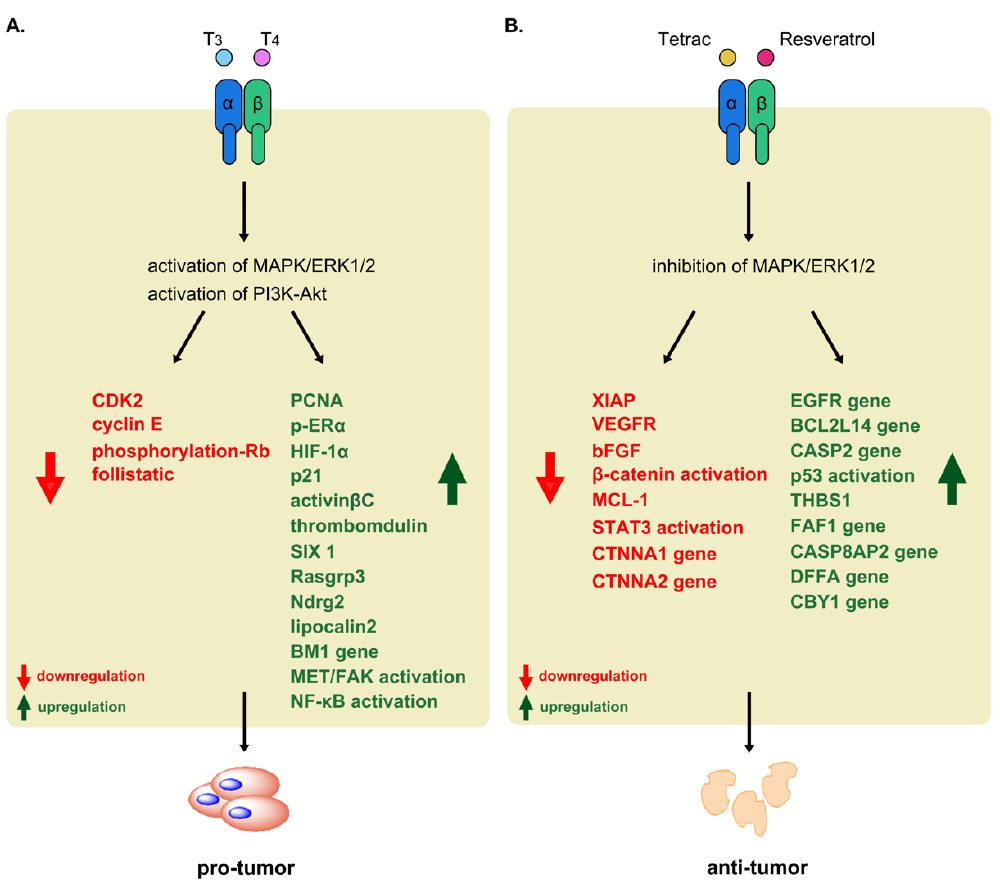
Figure 5. Non-genomic e ff ects of pro-tumorigenic and anti-tumorigenic activities of thyroid hormones in tumor settings. ( A ) α v β 3 that binds both T 3 and T 4 , leading to activation of MAPK / ERK1 / 2 and PI3K-Akt, inducing of PCNA, HIF-1 α , P21, activin β C, thrombomodulin, SIX1 Rasgrp3, Ndrg2, lipocalin2 and BM1 gene expression to promote phosphorylation of ER α , and activation of MET / FAK, NF- κ B, and downregulation of CDK2, cyclin E, phosphorylation of Rb and follistatin, respectively. ( B ) Tetrac can inhibit T 4 and T 3 interactions with the cell surface receptor site of integrin α v β 3 and blocks TH-mediated activation of MAPK / ERK1 / 2 by principal iodothyronines. Tetrac and resveratrol compete with the binding site on integrin α v β 3, leading to blockage of cancer cell responses to TH, leading to upregulation of mRNA of EGFR, BCL2L14, CASP2, FAF1, CASP8AP2, DFFA, CBY1, p53 and TSBH1. Conversely, they downregulate CTNNA1, CTNNA2, XIAP, VEGFR, bFGF mRNA expression as well as inhibit β -catenin and STAT3 activation.